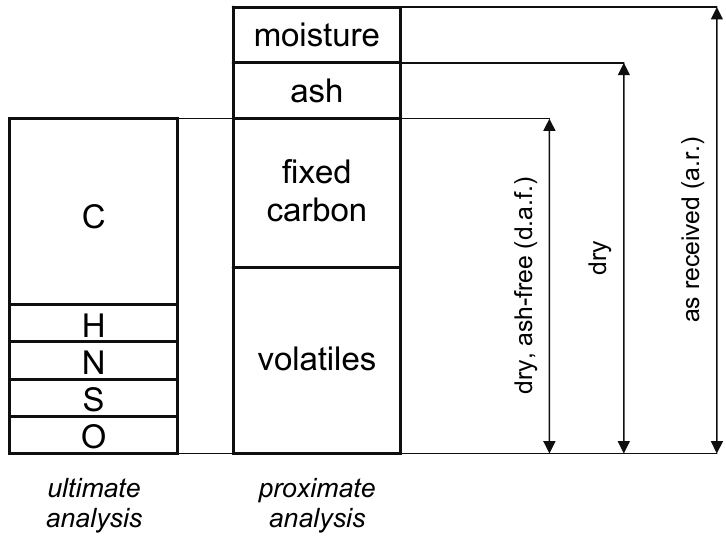
Figure 3 . General composition and main chemical elements in typical solid organic fuels.